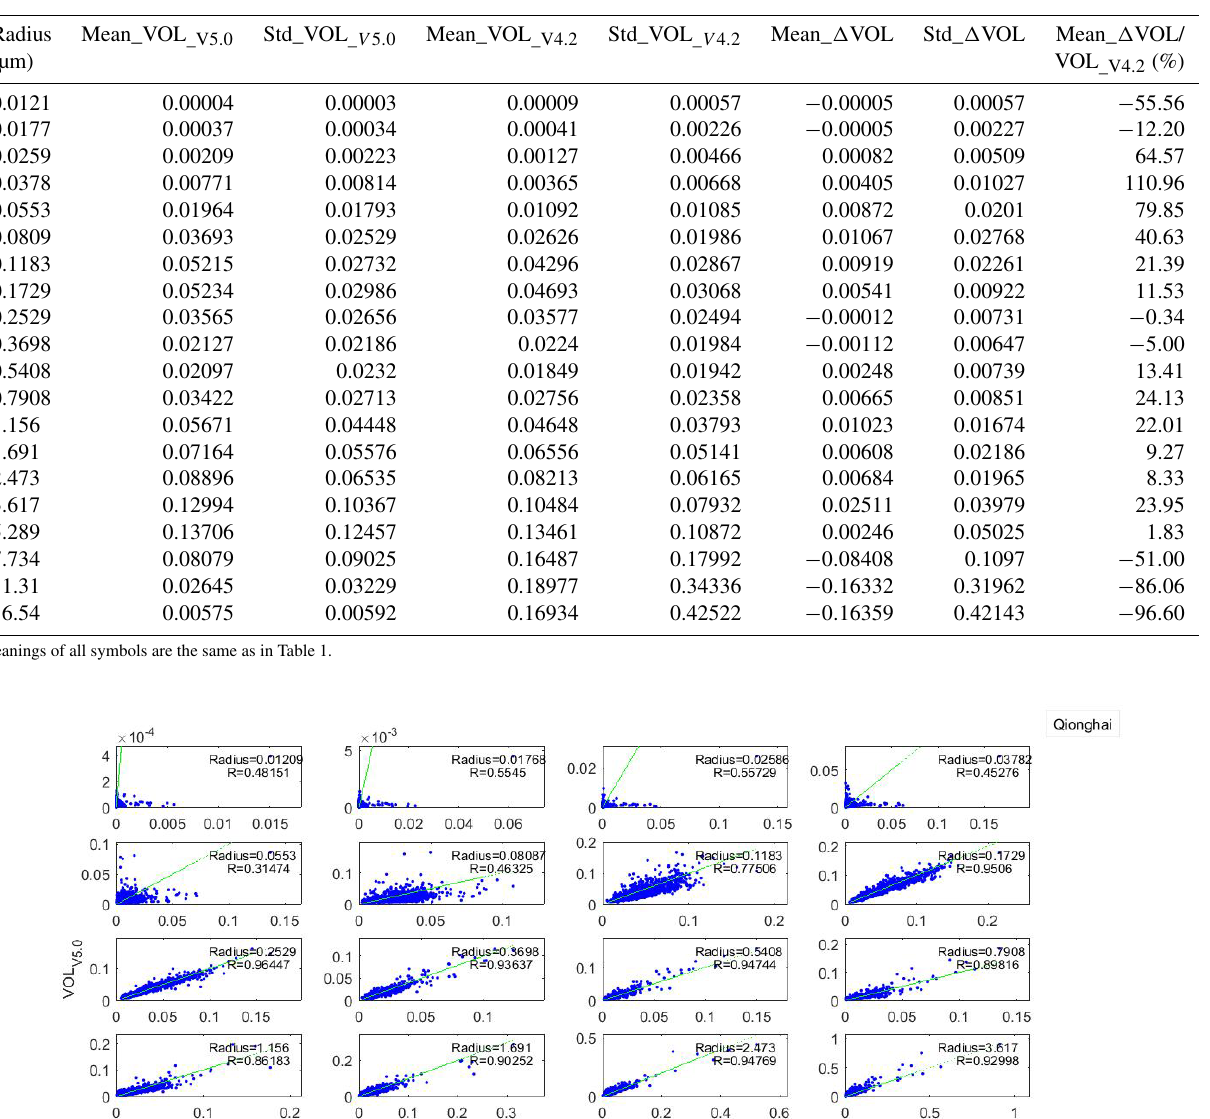
Table 2. The same as Table 1 but for Yucheng during February 2013 to December 2015.